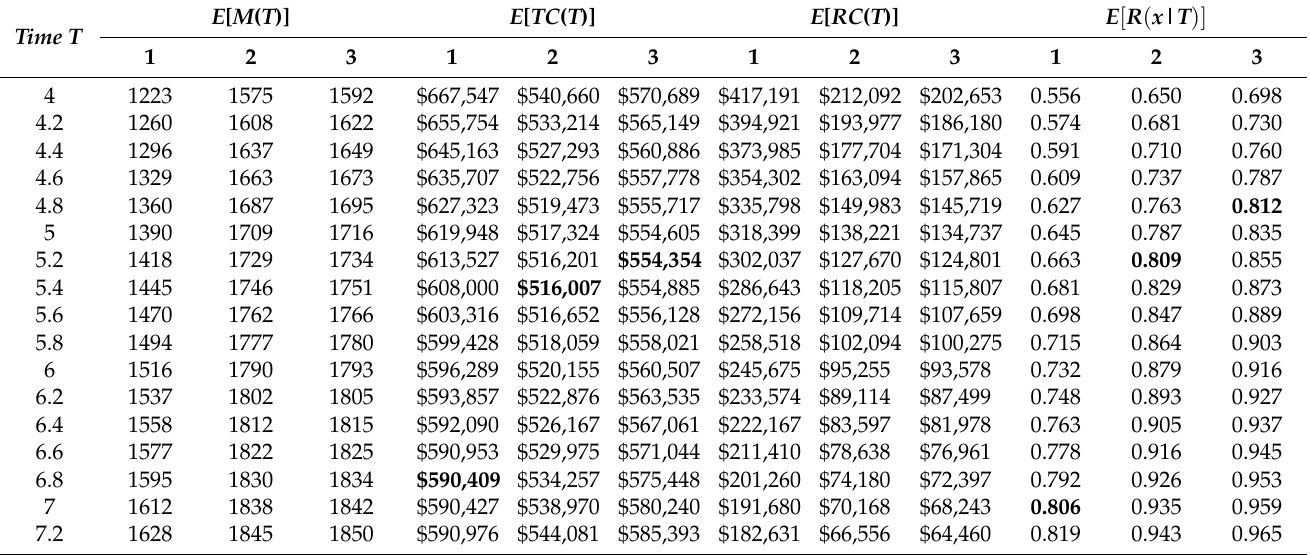
Table 5. E [ M ( T )] , E [ TC ( T )] , E [ RC ( T )] and E [ R ( x | T )] of alternatives 1, 2, and